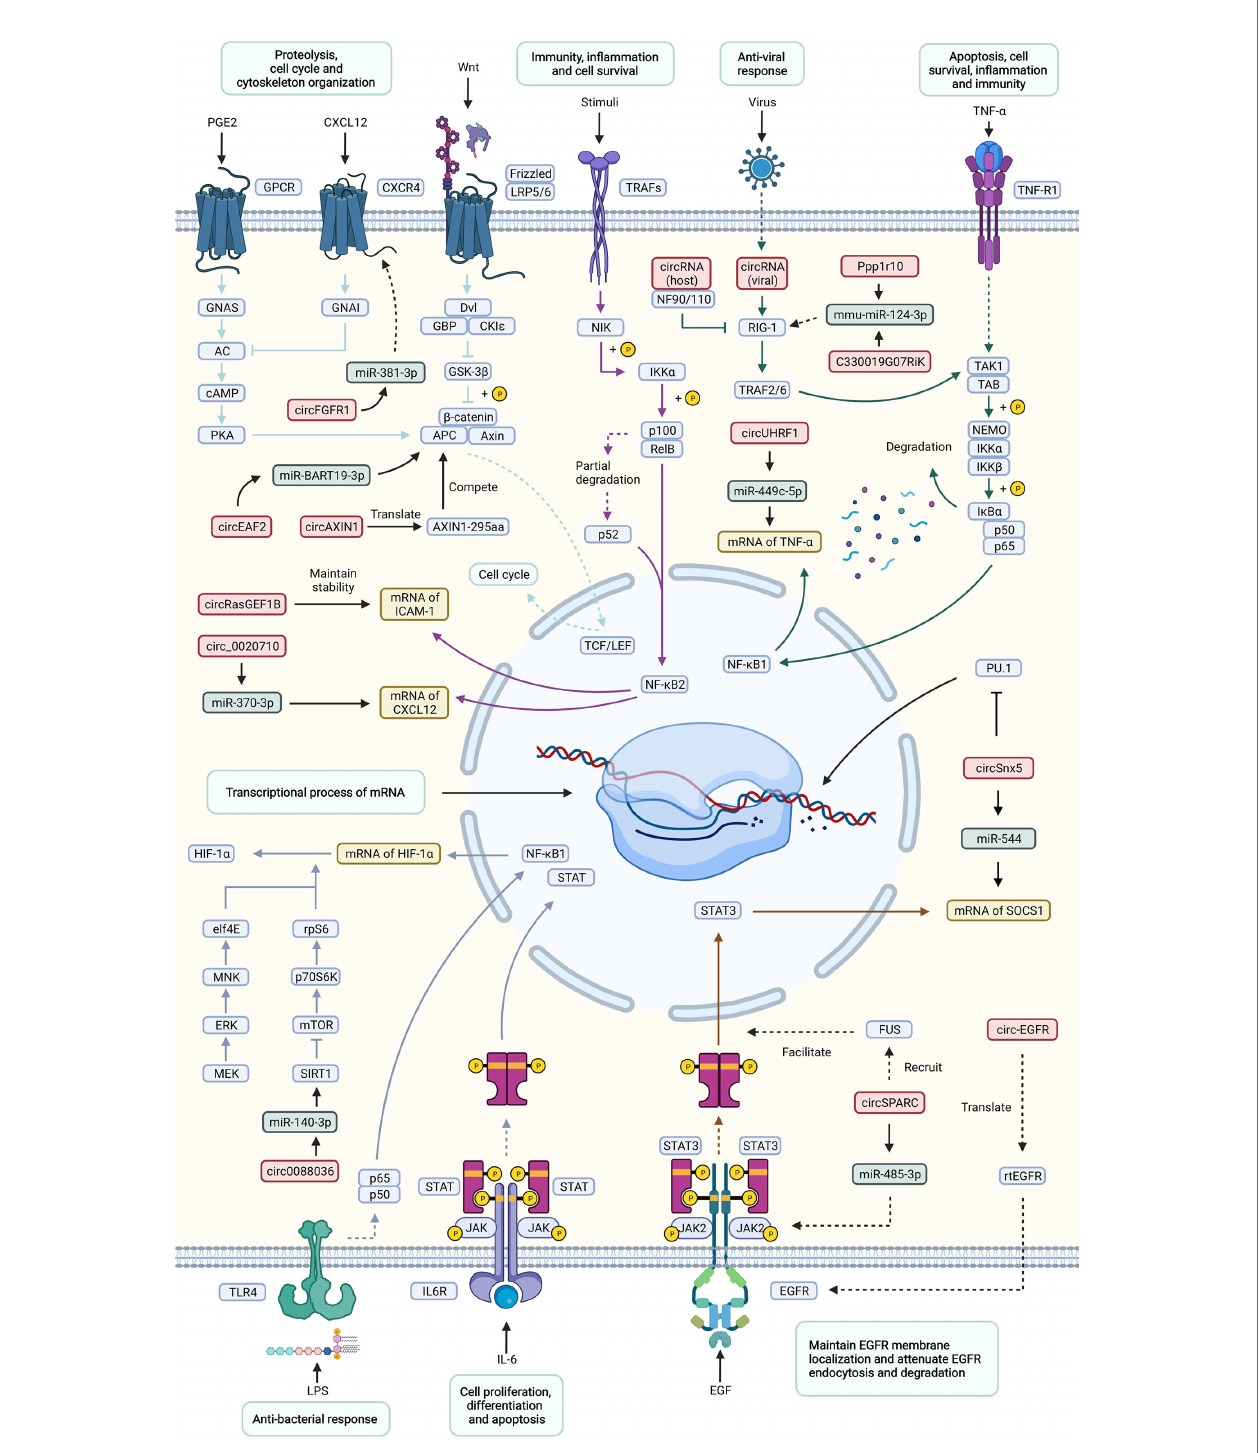
FIGURE 3 | Important signaling pathways of circRNAs involved in the regulation of immune-related diseases. This fi gure shows how circRNAs in fl uence immune- related diseases via a variety of signaling pathways, including the Wnt, TNF, NF- k B, JAK-STAT, mTOR, antiviral and antibacterial pathways. and the corresponding responses. Effects and processes are shown in light green rectangles, circRNAs are shown in red rectangles, miRNAs are shown in dark green rectangles, mRNAs are shown in yellow rectangles, and proteins are shown in blue rectangles. Different signaling pathways are distinguished by arrows and inhibitors of different colors. Solid lines represent direct interactions between molecules, while dotted lines represent indirect